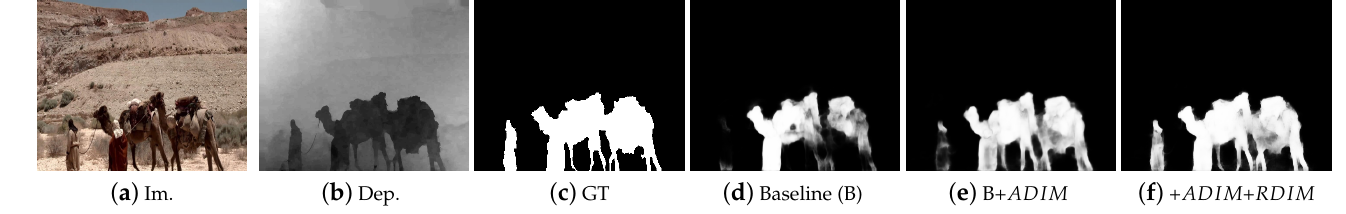
Figure 1. Effectiveness of absolute depth information and relative depth information. ( a ) Input image; ( b ) depth image; ( c ) ground truth; ( d ) saliency map generated by baseline network; ( e ) saliency map using absolution depth information; ( f ) saliency map using both relative depth information and absolute depth